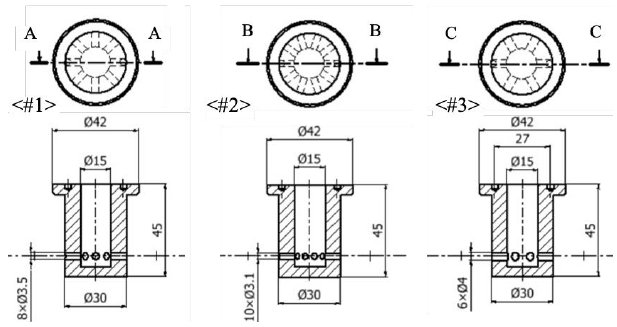
Fig. 2. Cross-sectional view of the PC tip #1~#3